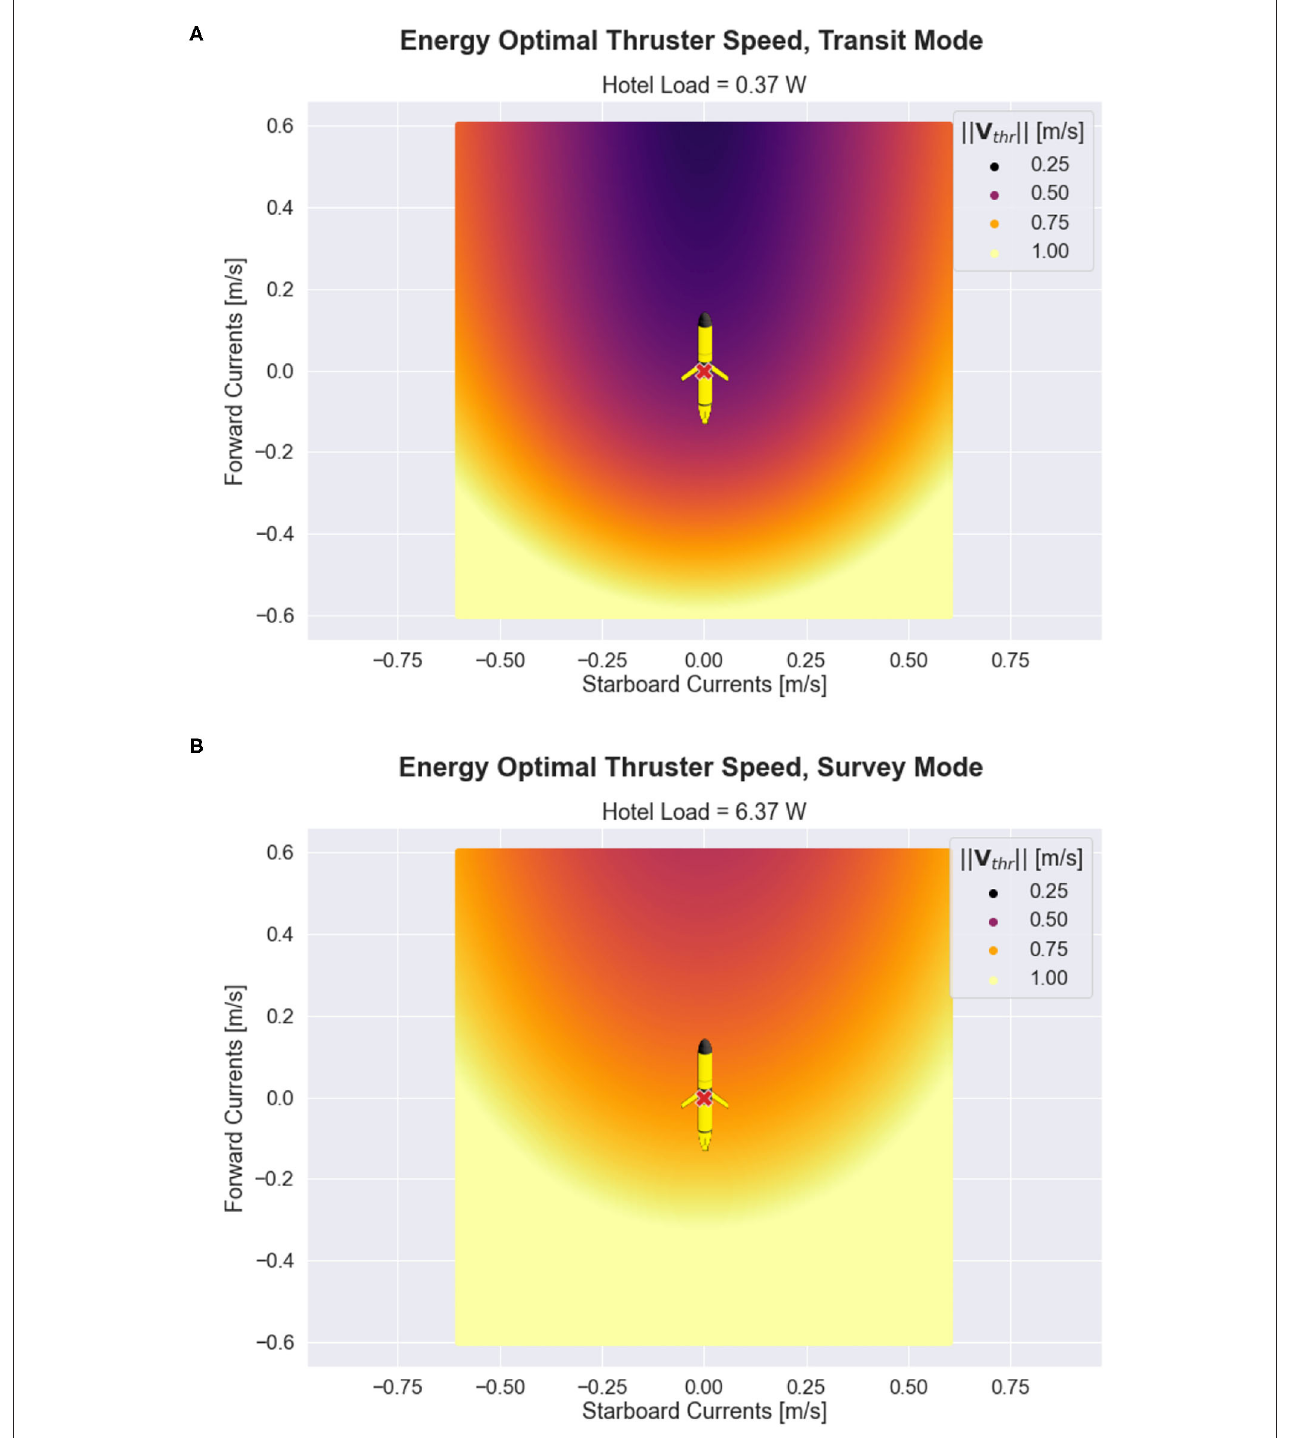
FIGURE 5 | Adaptive velocity control (AVC) in 2D for ocean current speeds ≤ 0.6ms − 1. In each subplot, the x-coordinate represents the starboard (cross-track) component of the ocean current velocity, and the y-coordinate represents the forward (long-track) component of the ocean current velocity. The glider is centered at the origin. The color shown in (A,B) represent the optimal glider thruster water speed for transit and survey hotel, according to the AVC method presented in Equation (20).